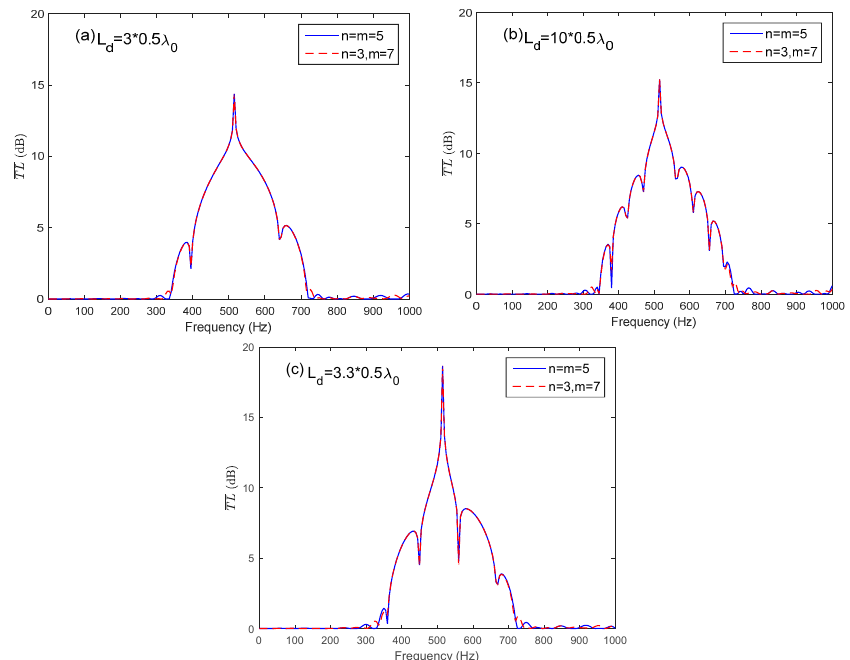
Figure 9. Comparison of two arrangement cases ( n = m = 5 and n = 3, m = 7) with identical number of HRs and connection tube length L d : ( a ) two different arrangements with same L d = 3 × 0.5 λ 0 ; ( b ) two different arrangements with same L d = 10 × 0.5 λ 0 ; ( c ) two different arrangements with same L d = 3.3 × 0.5 λ 0 .